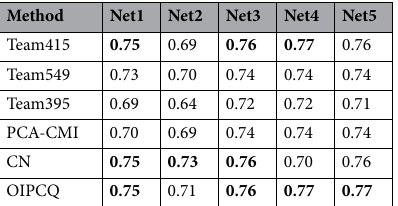
Table 11. Comparison of different methods for Learning DREAM4 Challenge. TeamName is the name of the team which registered for this challenge. The best performer for the relative item is noted in bold.